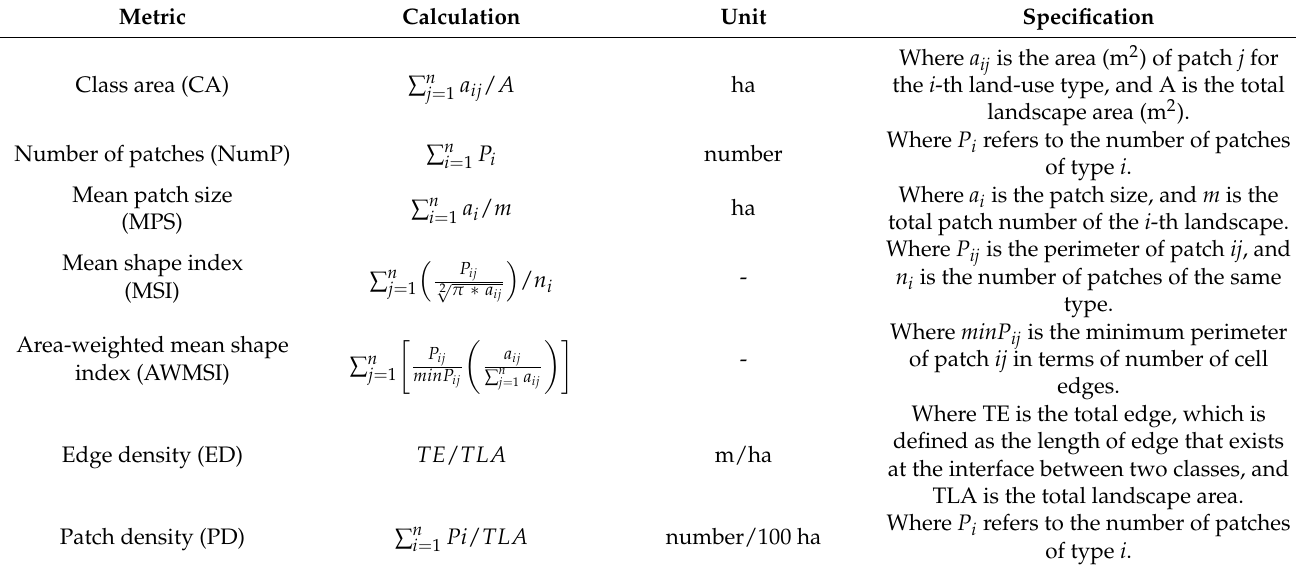
Table 5. Landscape matrix indicator